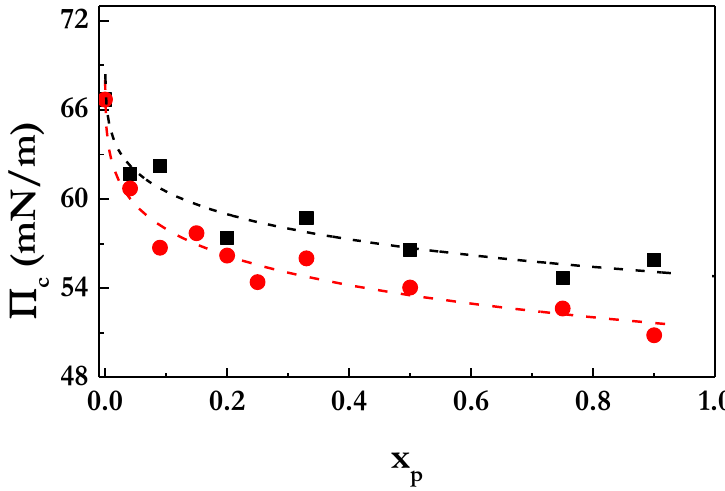
Figure 3. Dependence on x p of the collapse pressure, Π c, of DPPC monolayers upon the incorporation of CB ( ■ ) and SiO 2 (●) particles. Note that the lines are guides for the eyes.